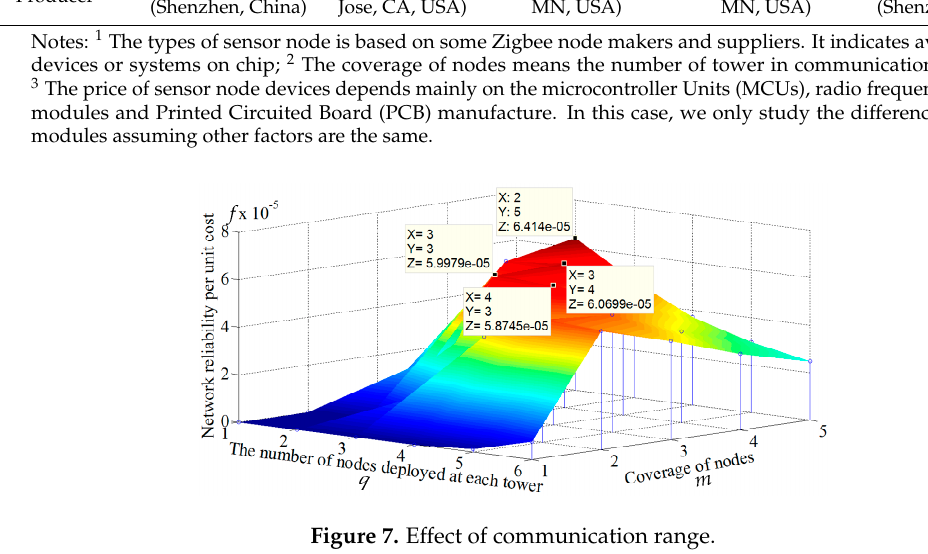
Figure 7. Effect of communication range.